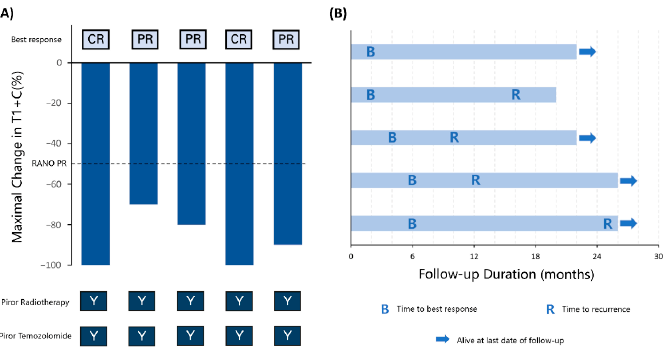
Figure 1. ( A ) Maximal change in the product of the perpendicular diameter in MRI T1 contrast before and after HSRT with anlotinib in each patient. CR, complete response. PR, partial